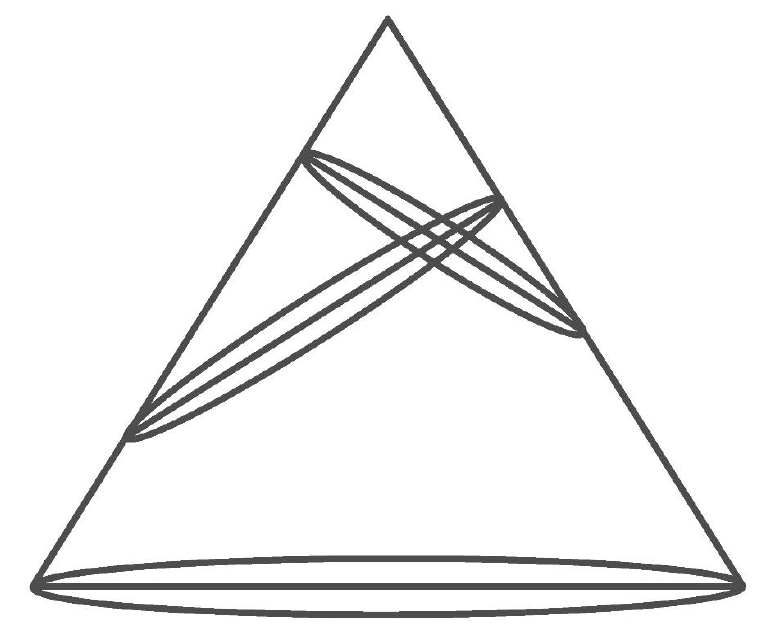
Figure 2. Example of conic subcontraries, namely two conics such that the planes on which they lie are both perpendicular to the same plane passing through the axis of the cone and perpendicular to the base, and detach from the triangle by the axis, starting from the vertex of the cone to two subcontraries triangles.